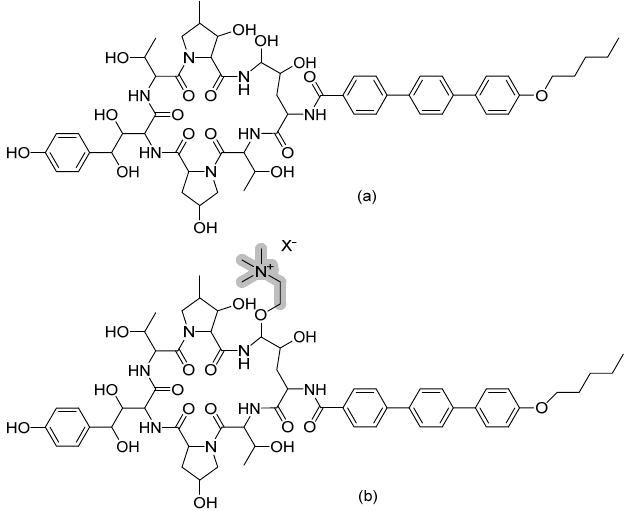
Figure 15. The chemical structures of ( a ) anidulafungin and ( b ) rezafungin. The chemical modifica- tion in the structure of rezafungin over anidulafungin is highlighted in